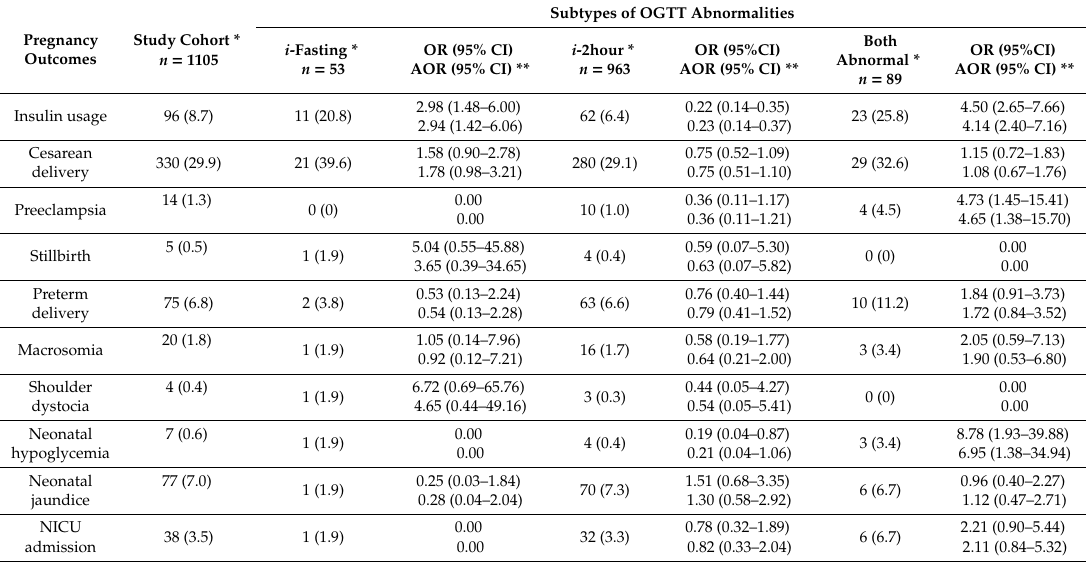
Table 2. Pregnancy outcomes for the study population and the OGTT abnormalities subtypes. Pregnancy